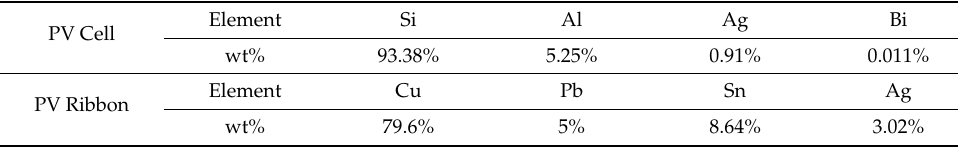
Table 1. The composition of the PV cell and the